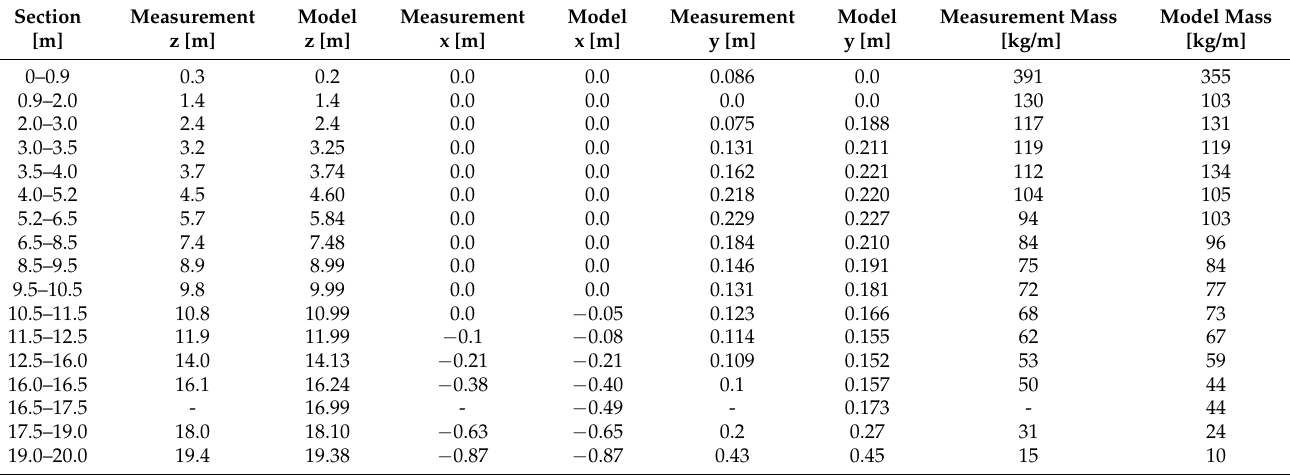
Table 8. Section-wise measured centre of mass in global coordinates mass per length.